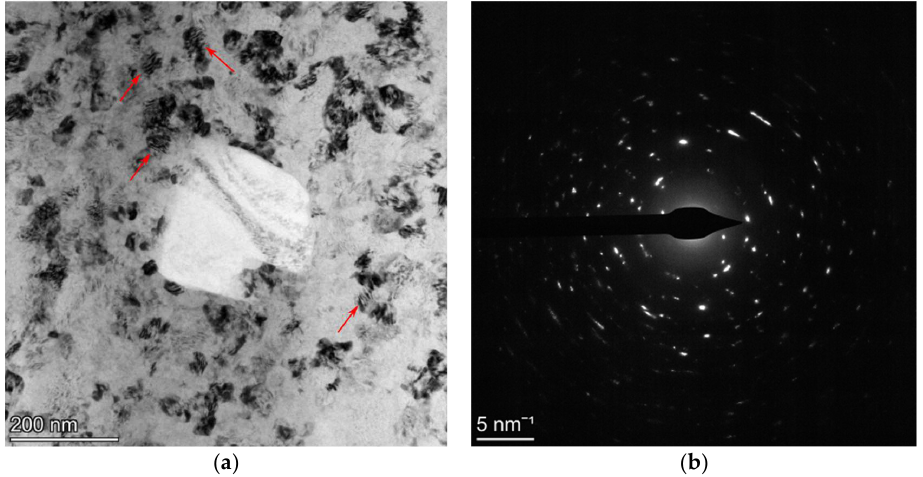
Figure 5. TEM micrograph of the powder C 60 ( a ) showing the UFG microstructure a size of about 50 nm with a very high dislocation density of the order of magnitude of 10 16 m/m 3 (estimated from the distances between dislocations; about 10 nm detected in the grains are pointed by arrows) and a rather exceptional large undissolved Y 2 O 3 particle, and ( b ) showing the selected area elec- tron diffraction pattern of the UFG microstructure and proving the developed crystal structure of the grains.